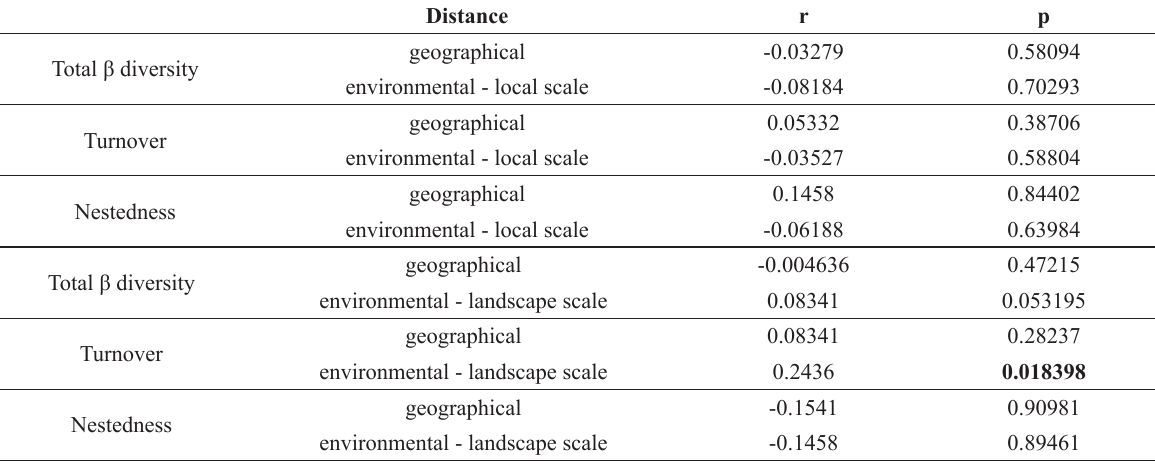
Partial Mantel test values (r = the correlation coefficient; p = level of significance) considering geographical and environmental distances at the local scale, and geographical and environmental distances at the landscape scale of the 17 forest